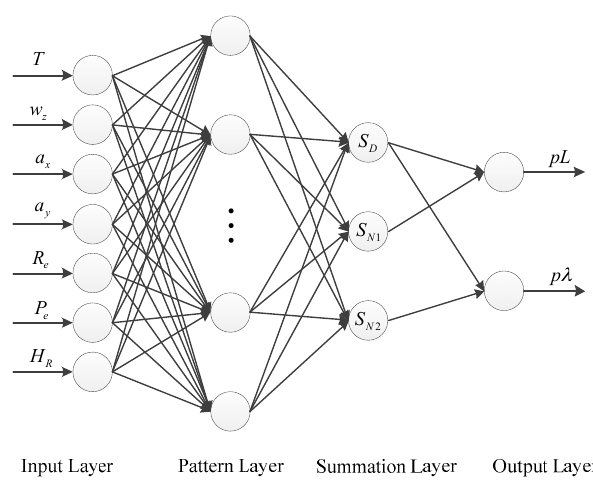
Figure 3. Schematic diagram of GRNN for the application in this paper.